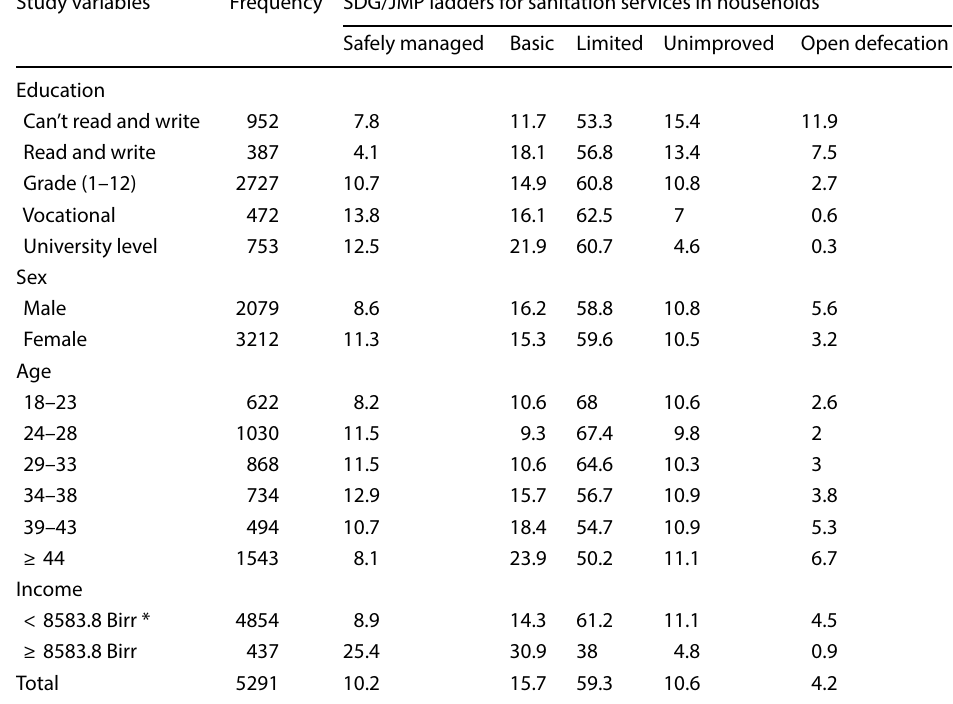
Table 2 Percentage of sanitation service ladders of households by sociodemographic characteristics of